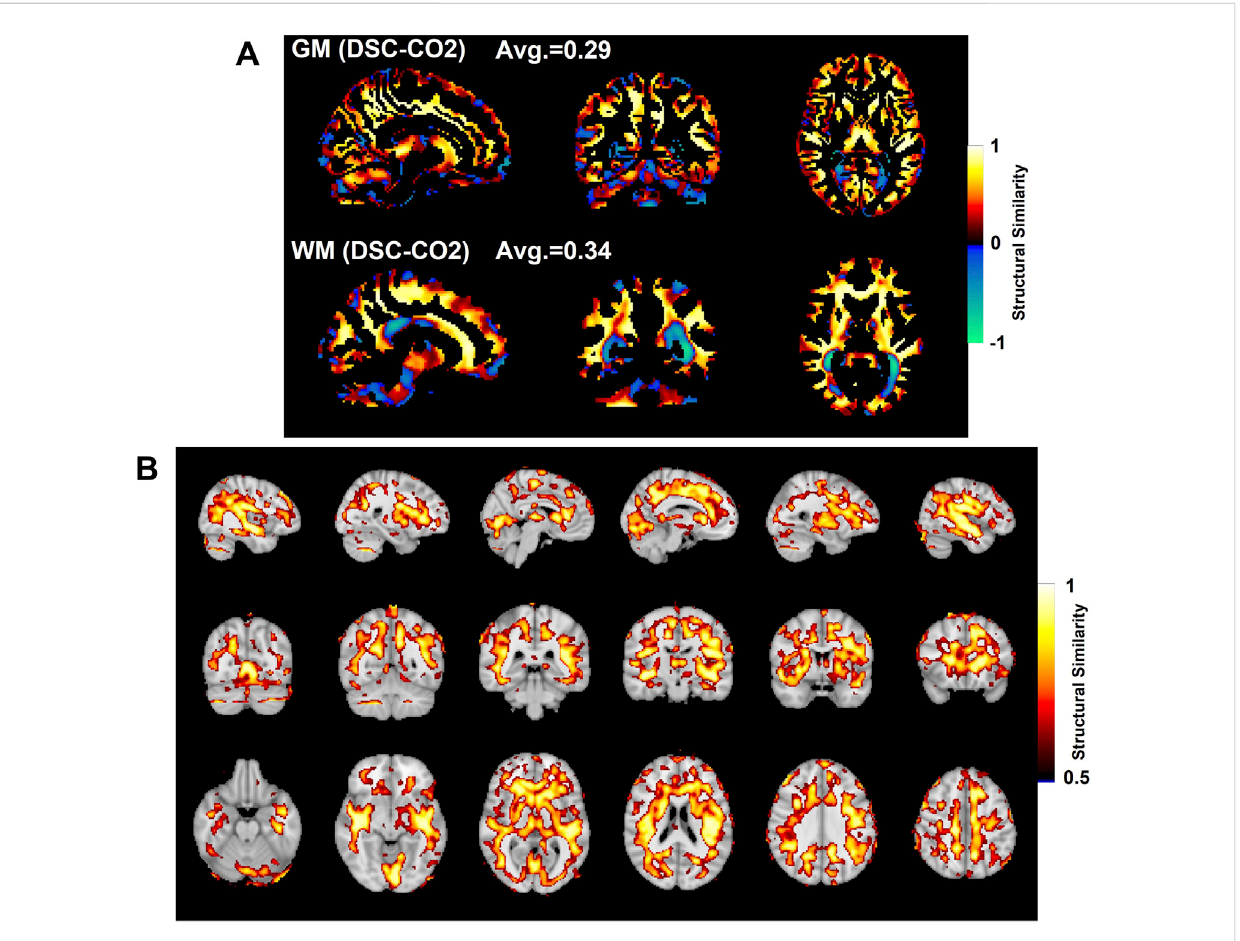
FIGURE 5 Comparison of SSIM values in gray matter (GM, top) and white matter (WM, bottom) shown in (A) . SSIM maps compare the subject-averaged DSC bolus arrival delay map with the subject-averaged CO 2 arrival delay map. Voxels with SSIM values greater than 0.5 are shown in (B) .